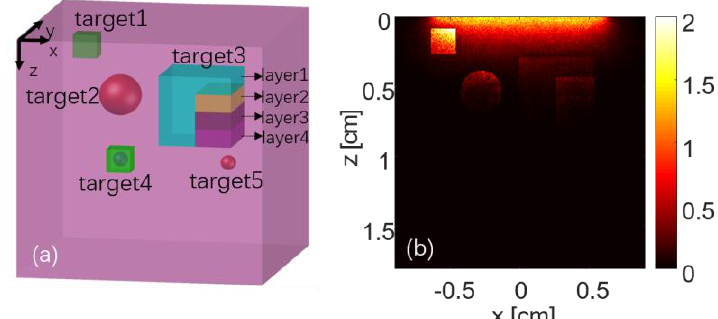
Figure 2. ( a ) Complex numerical simulation 3D model, different objects are distinguished by different colors and shapes. ( b ) Measured absorption energy distribution, for the selected z-x section (y = 0 cm). The axes z and x (left and bottom) illustrate the spatial scale, the unit is cm, whereas the color scale (right) represents the absorbed energy density.